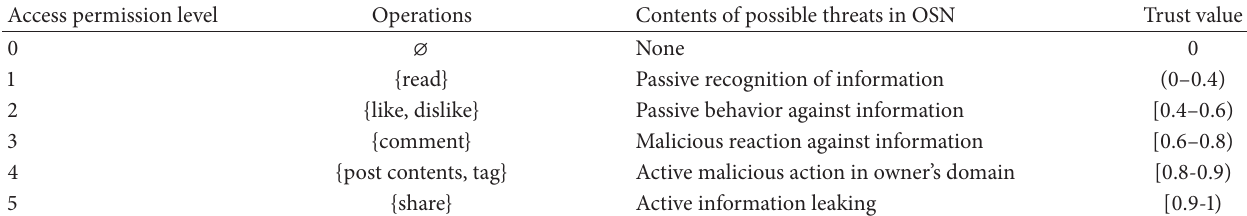
Table 4: Operation examples for user actions with trust level in OSN environment.